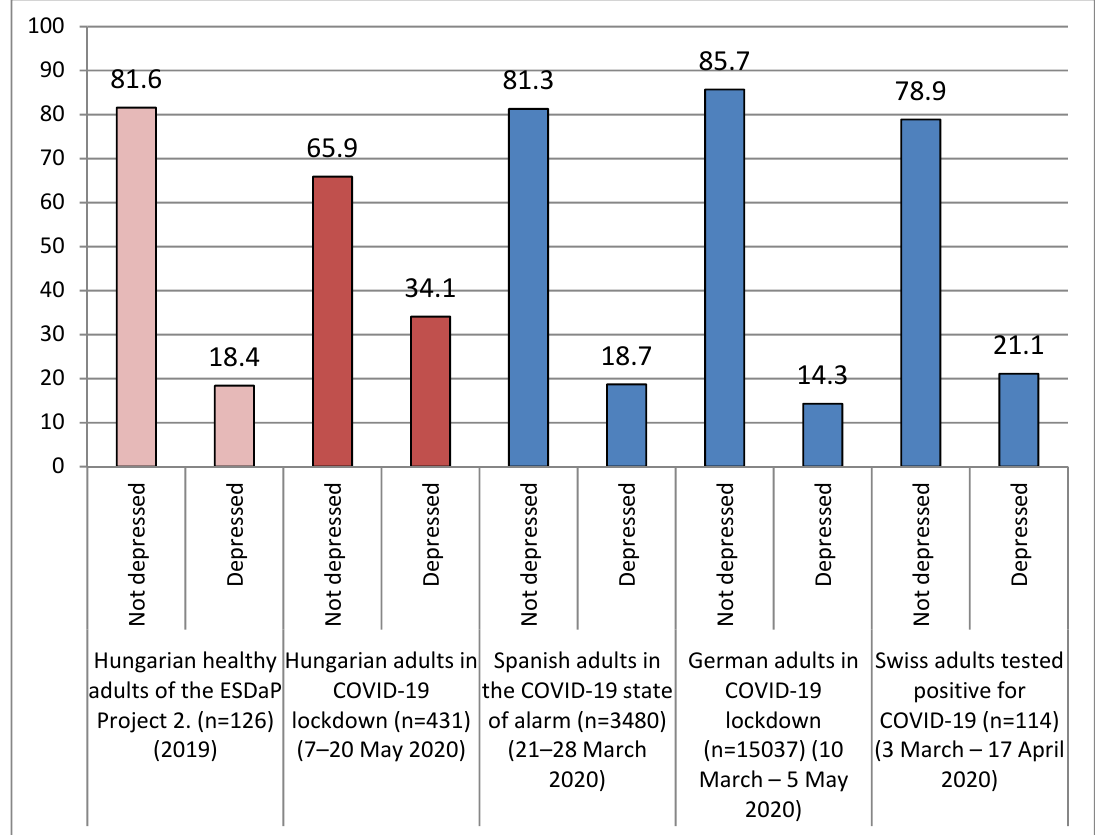
Figure 4. Frequencies of depressed versus not depressed cases (measured with the Patient Health Questionnaire (PHQ)-2 scale) at Hungarian adults ( n = 431) during coronavirus lockdown compared to previous Hungarian scores and other countries’ residents’ scores during the COVID-19